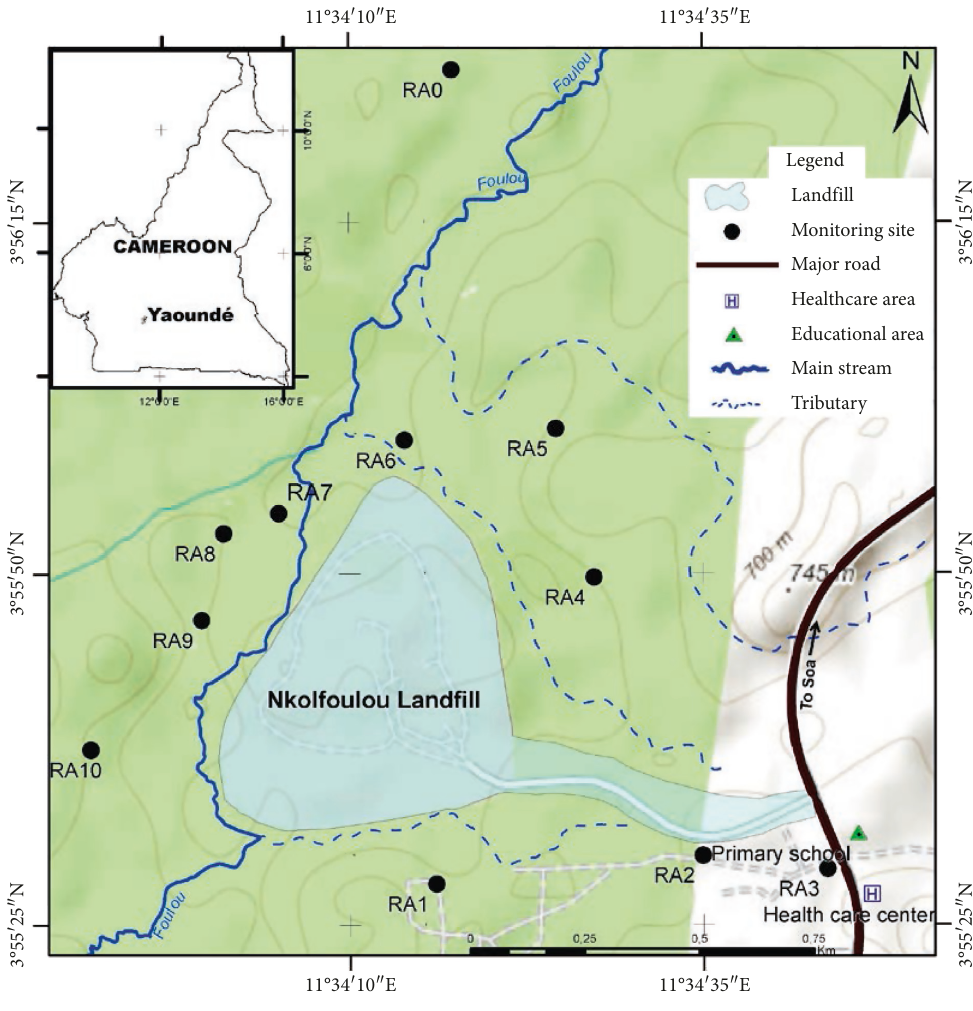
Figure 1: Map of the study Table 2: Concentration of particulate matter at the monitoring sites ( n � 24).